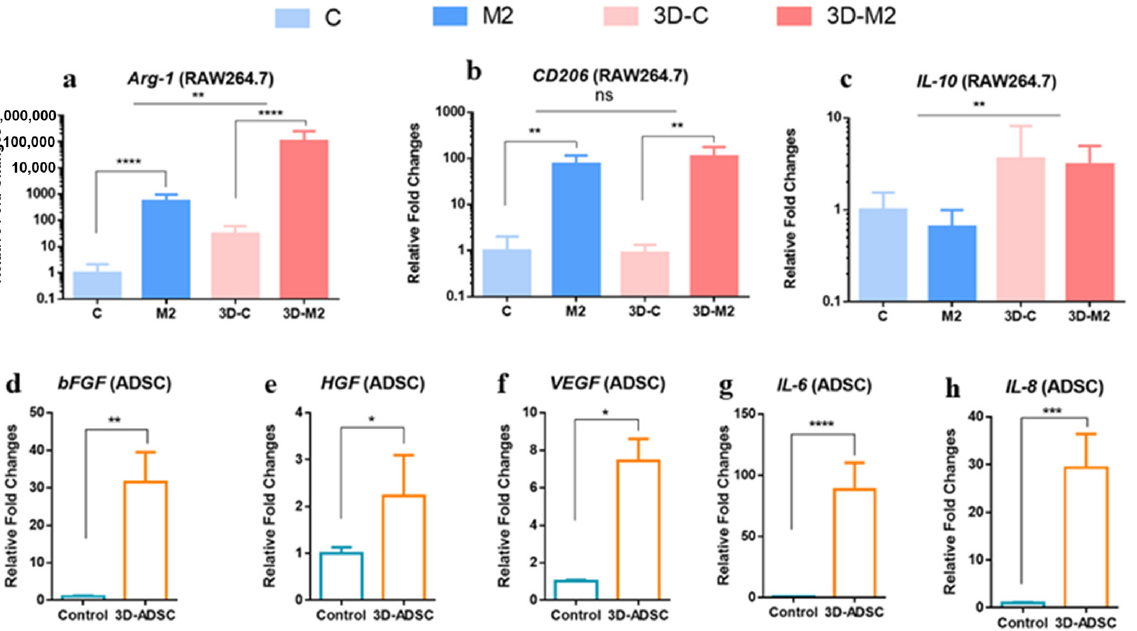
Figure 5. qRT-PCR results of classical cytokines expression of RAW246.7 and ADSC cells encapsulated in a microsphere and a 2D culture environment: ( a ) Arg-1 expression from RAW246.7; ( b ) CD206 expression from RAW246.7; ( c ) IL-101,000 expression from RAW246.7; ( d ) bFGF expression from ADSC; ( e ) HGF expression from ADSC; ( f ) VEGF expression from ADSC; ( g ) IL-6 expression from ADSC; ( h ) IL-8 expression from ADSC. n = 3, * p < 0.05, ** p < 0.01, *** p < 0.001, **** p < 0.0001. 2.6. Influence on Expression of Inflammation Regulating Cytokines in Encapsulated RAW246.7